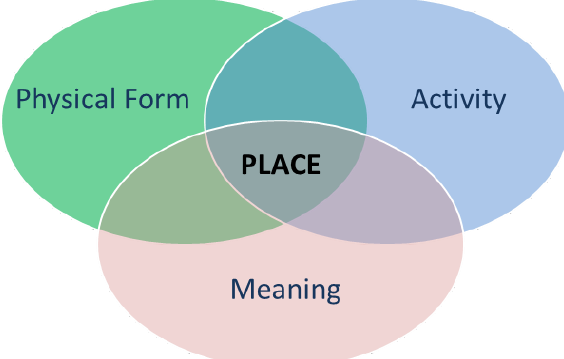
Figure 1. Montgomery’s concept of place (Montgomery,